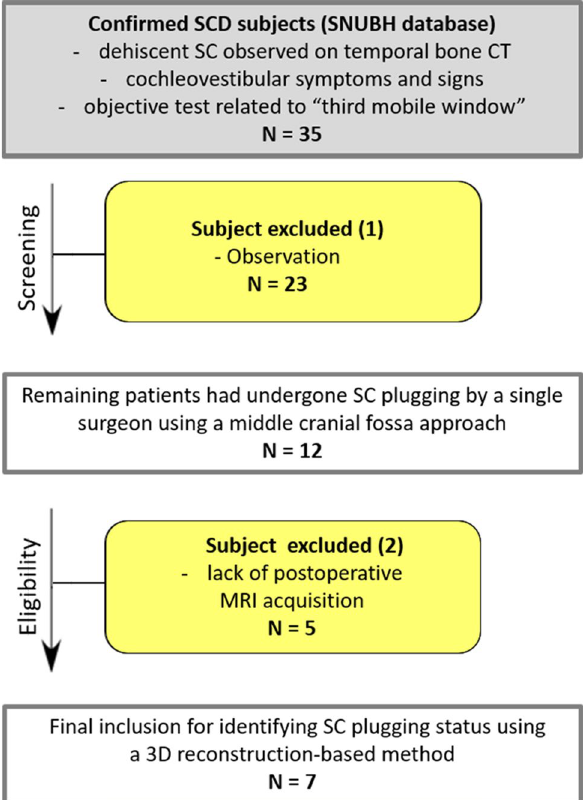
Figure 1. Flow diagram of the inclusion and exclusion criteria for identifying superior semicircular canal (SC)-plugging status using a 3D reconstruction-based method. SCD superior semicircular canal dehiscence, CT computed tomography, 3D three-dimensional, SC superior semicircular canal.